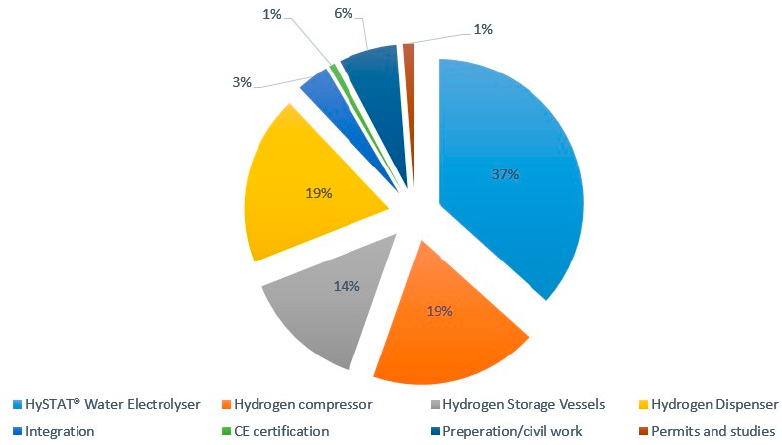
Figure 3. Investment expense share from phase 1.